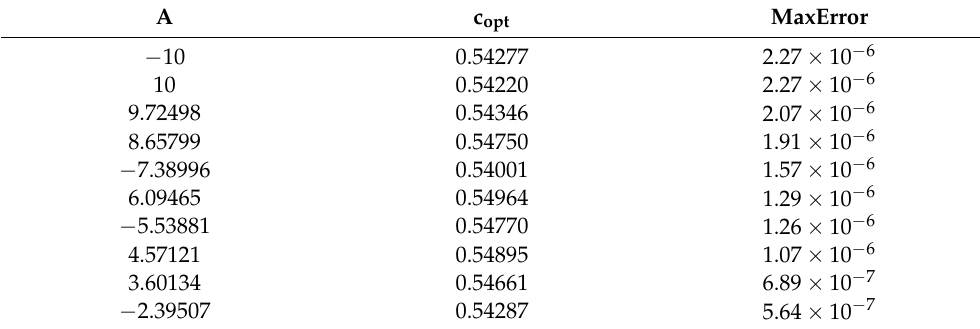
Table 3. Partial results of A ∈ [ − 10,10 ] .